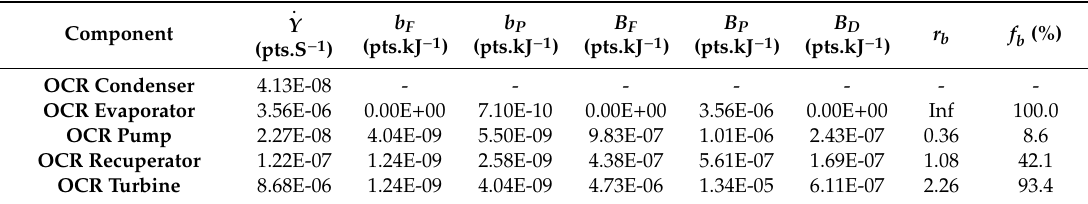
Table 11. Exergo-environmental results for standalone geothermal cycle